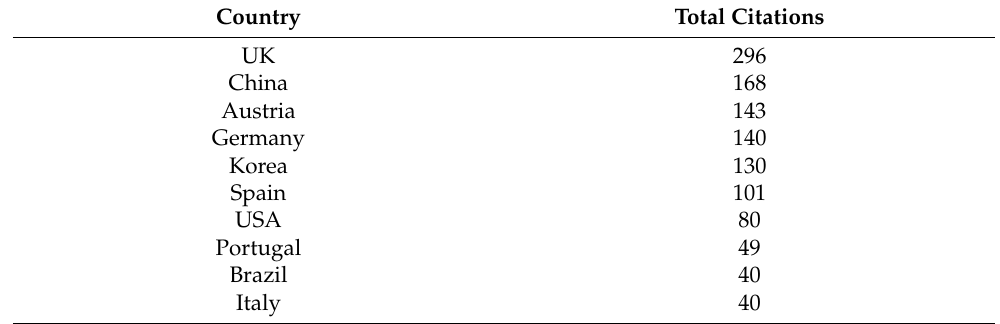
Table 15. Most Cited Countries (ROA).